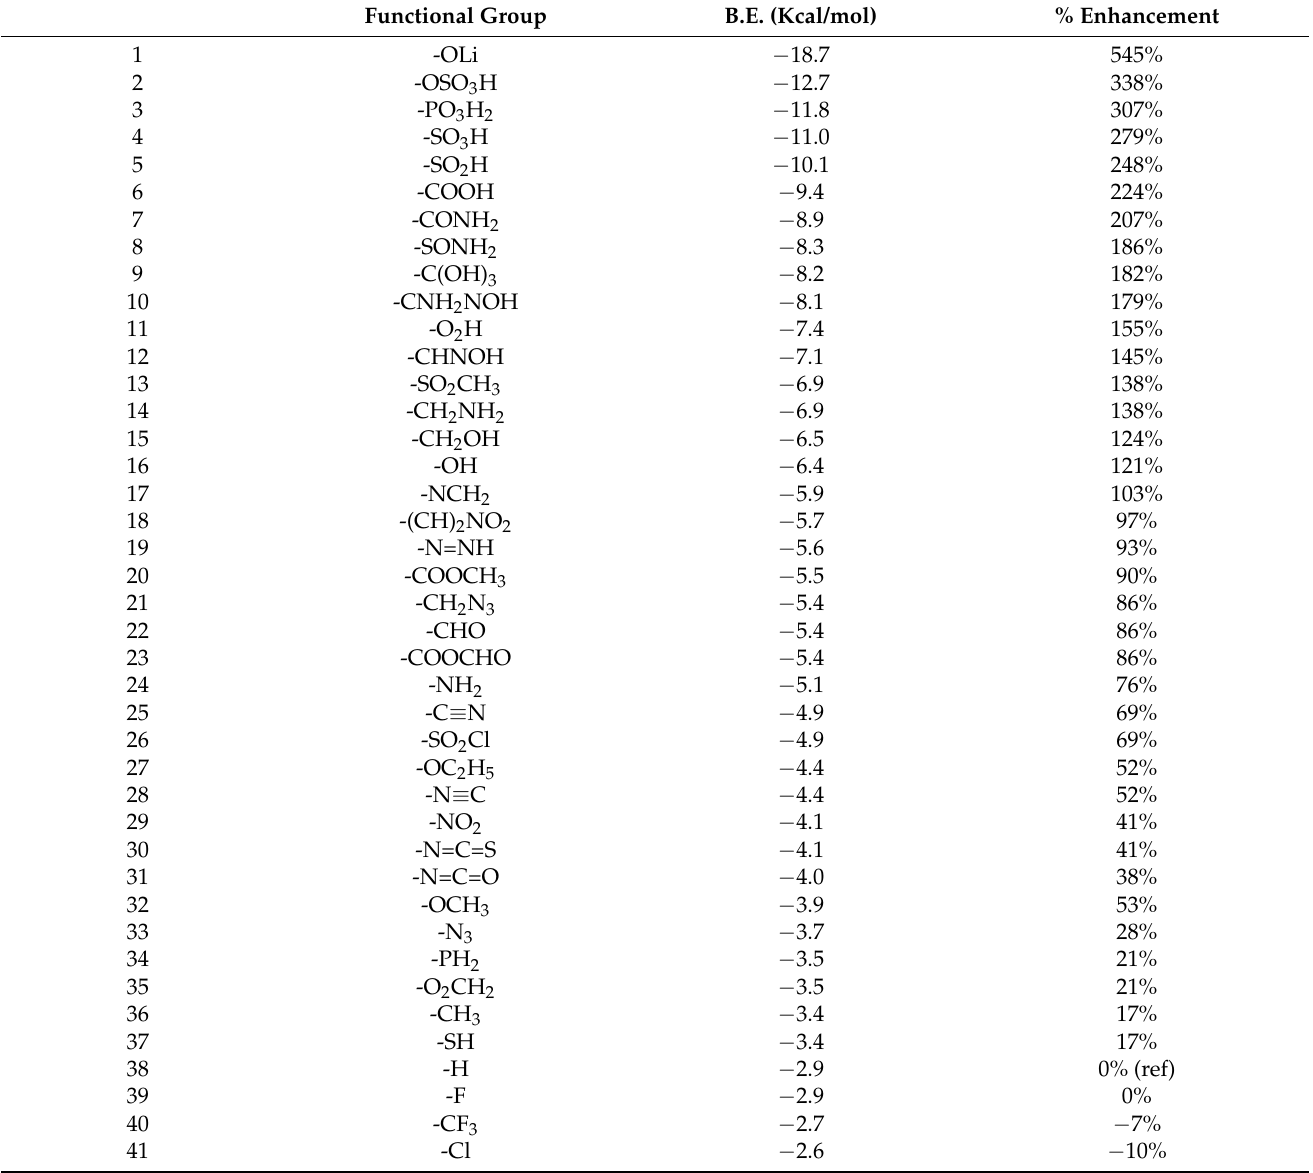
Table 1. Counterpoise-corrected interaction energies in Kcal/mol between the H 2 O molecule and the functionalized benzenes, obtained at the RI-MP2/def2-TZVPP